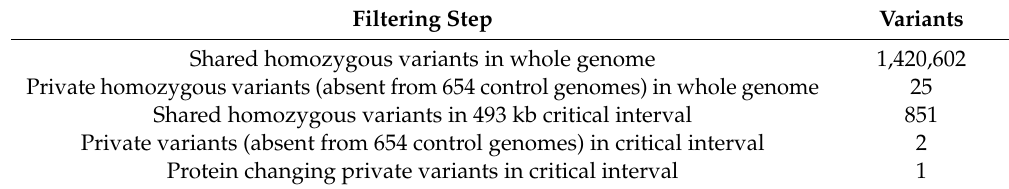
Table 1. Variants detected by whole genome re-sequencing of two ECLE-a ff ected